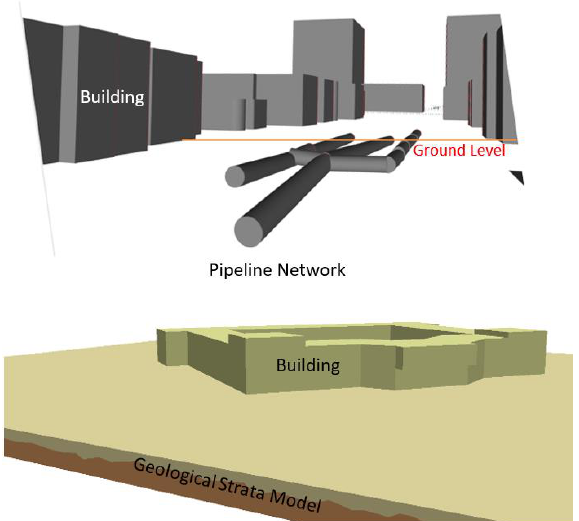
Figure 3. Creating a 3D model for some surfaces spatial object (building) and subsurface objects (pipeline networks and geological strata model)